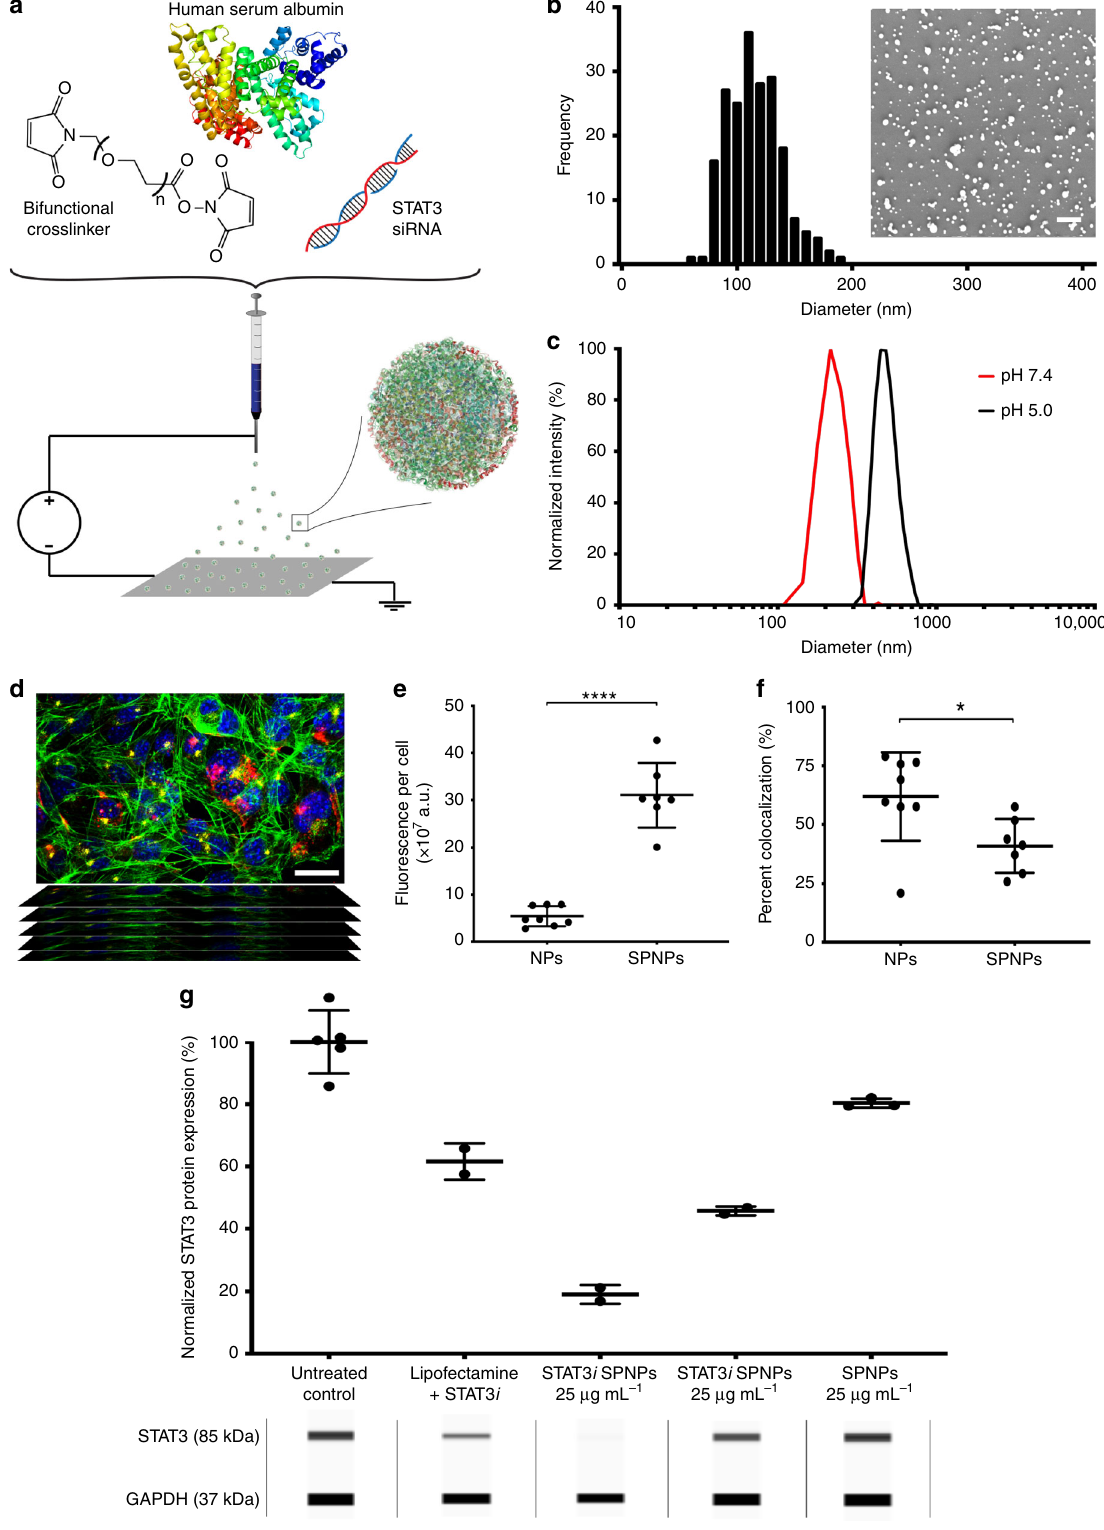
cells for a period of 30 min, particle uptake increased by ~5-fold compared to NPs without iRGD (Fig. 1e). Image analysis of 3D confocal images (Fig. 1d) using CellPro fi ler revealed that sig- ni fi cantly less particles colocalized with lysosomes of GL26 glioma cells compared to NPs without iRGD (Fig. 1f). These